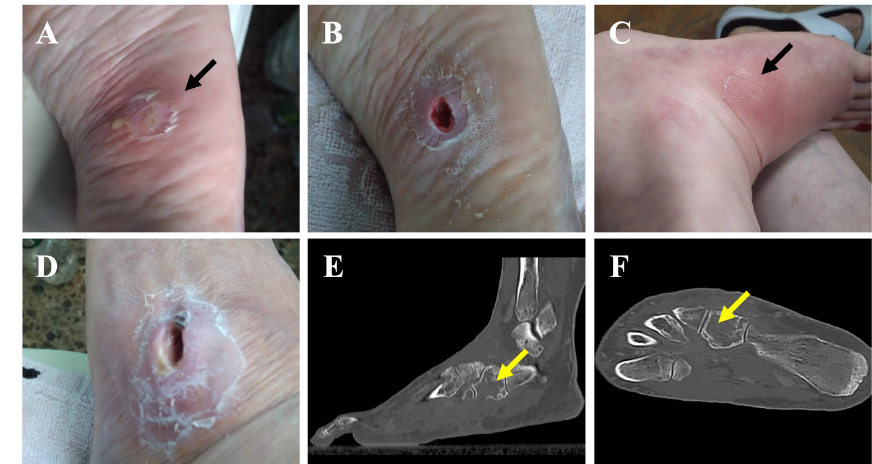
Figure 1. A plantar foot abscess following a puncture injury before (a) and after (b) debridement. The subsequent appearance of a dorso- lateral fistula after failed antibiotic treatment before (c) and after (d) debridement. (e, f) A CT scan showing cuboidal osteomyelitis with medullary bone destruction (yellow arrows).